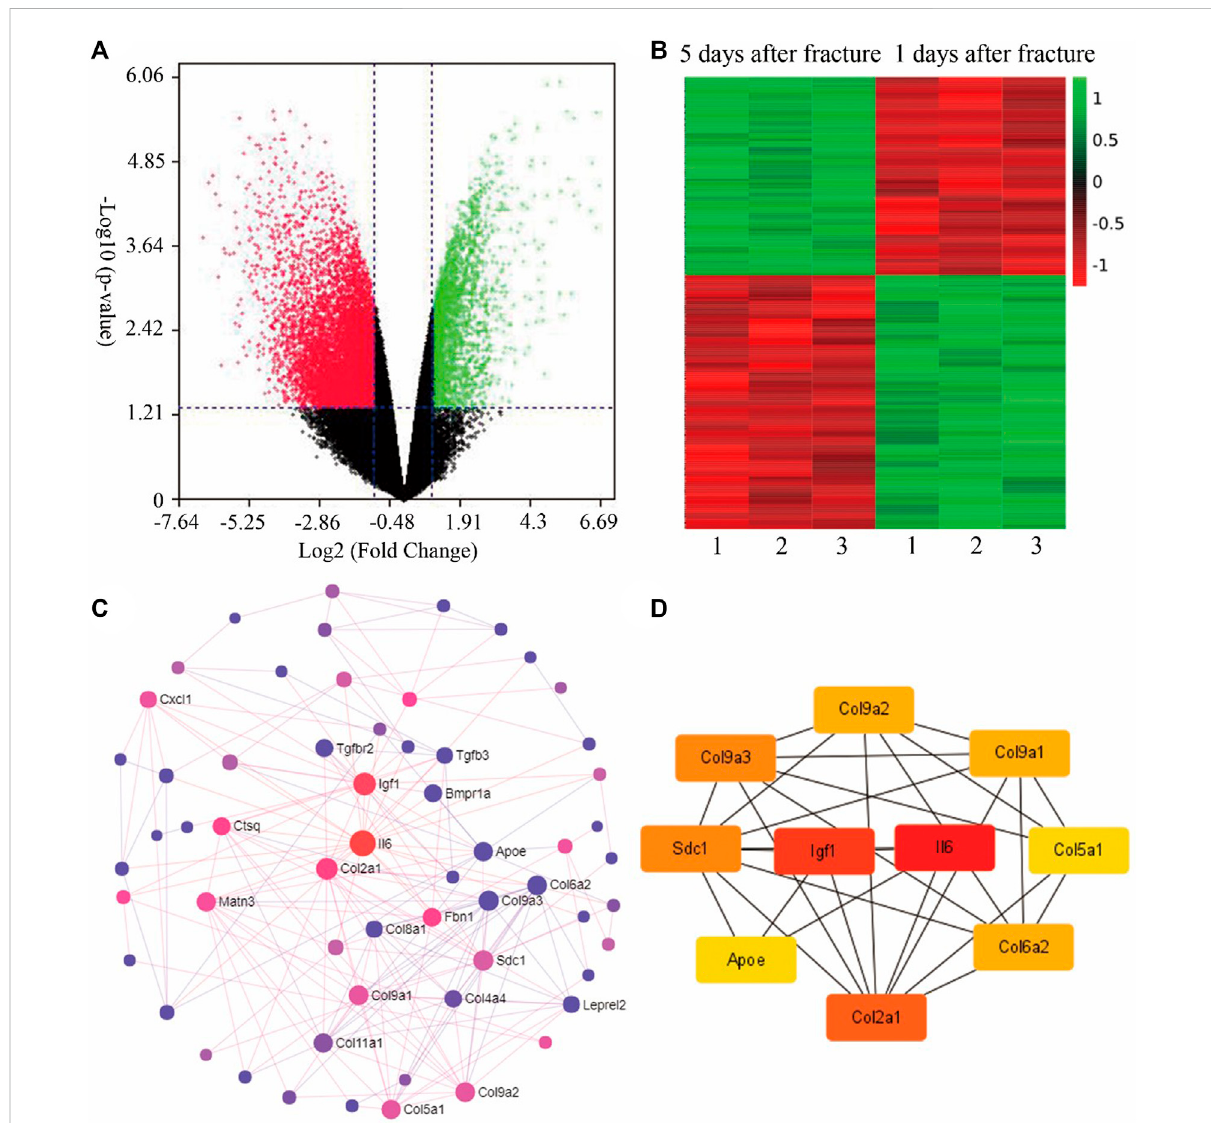
FIGURE 1 Bioinformatics analysis of fracture calluses at 1-day and 5-day post fracture of young mice (GSE17825). (A) The volcano plot for the gene expression in both groups. (B) According to the p -values, the heat map includes the expression of the top 250 differentially expressed genes of both groups. (C) Theprotein-proteininteraction(PPI)ofthetop100genesgeneratedbyStringandNetworkAnalyst. (D) Thetop10hubgenesanalyzedby Cytoscape, i.e. , Igf1, Il6, Col9a2, Col9a3, Sdc1, Apoe, Col2a1, Col6a2, and Col5a1. Col9a1 ( fi gures were plotted by https://www.bioinformatics. com.cn (last accessed on 30 July 2022), an online platform for data analysis and